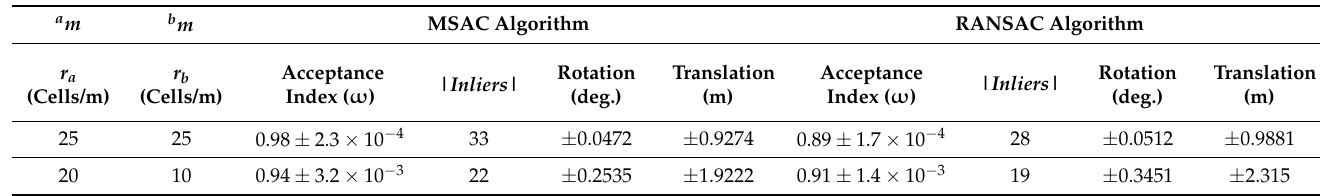
Table 2. Comparative results of performance parameters while merging maps of same and different grid resolutions using MSAC and RANSAC